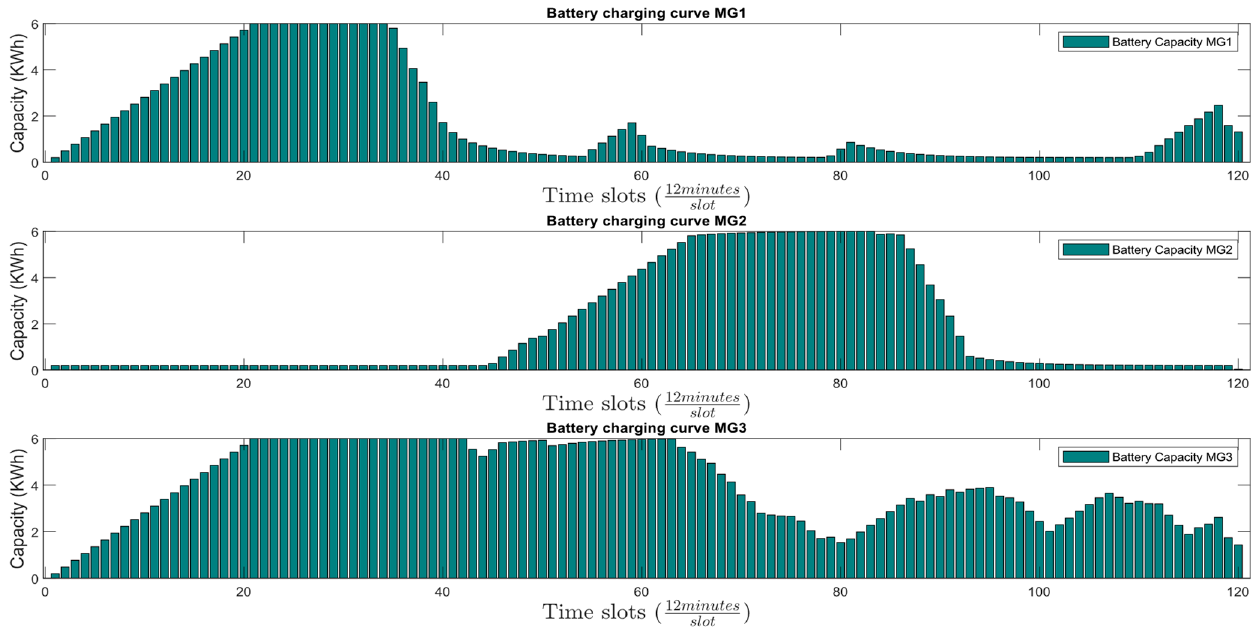
Figure 17. BESS capacity per slot for scheduled load using MJLBO.